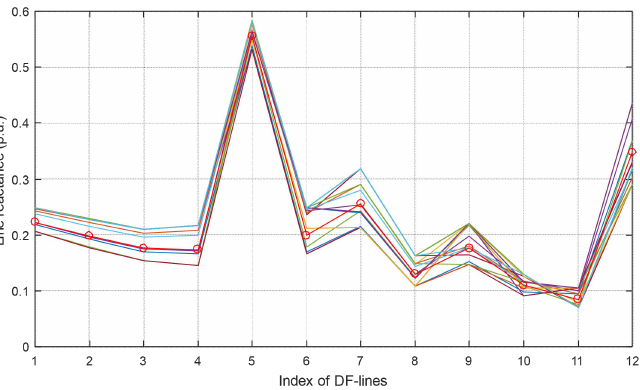
Figure 5. The reactance of D-FACTS-lines in 20 RHMTDs under a given load.